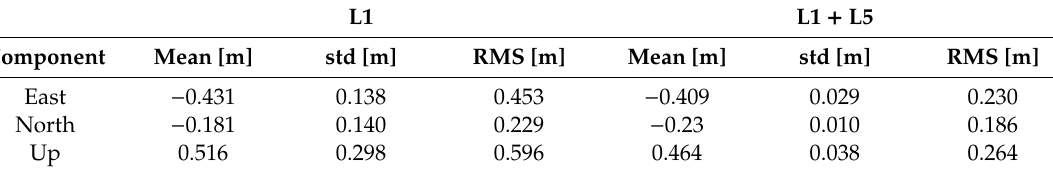
Table 5. Comparison of FIX + FLOAT solutions considering L1 and L1 + L5 frequencies.